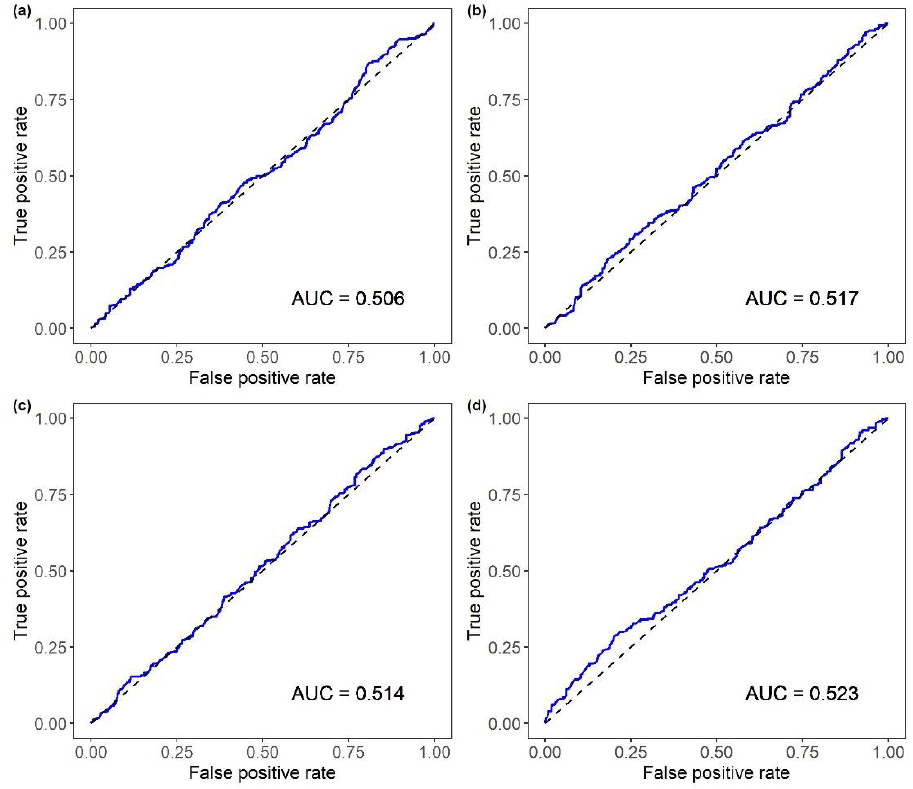
Figure A2. ROC curves for the classification of VNN mortality provided by breeding values estimated using only the information of full- and half-sibs of the individual (EBV FH ) for ( a ) mortality, ( b ) body weight, ( c ) square root of serum cortisol concentration and ( d ) antibody titer. AUC = area under the ROC curve.